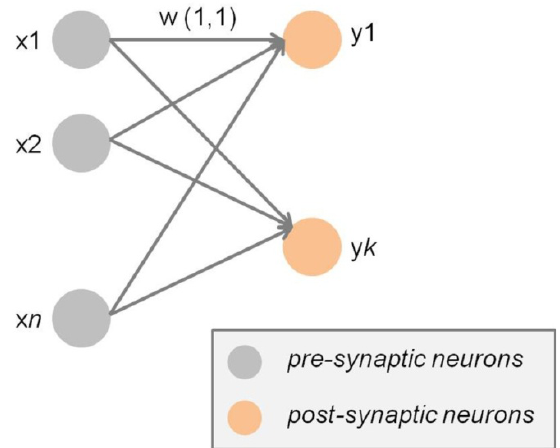
Figure 1. Schematic illustration of Hebbian synapses within a small neural network. Self-reinforcing synaptic learning is by definition unsupervised and involves the progressive increment of the synaptic weights (w) of efficiently stimulated connections, which are thereby long-term potentiated, while non-reinforced synapses will lose their efficiency and ultimately become long-term depressed.